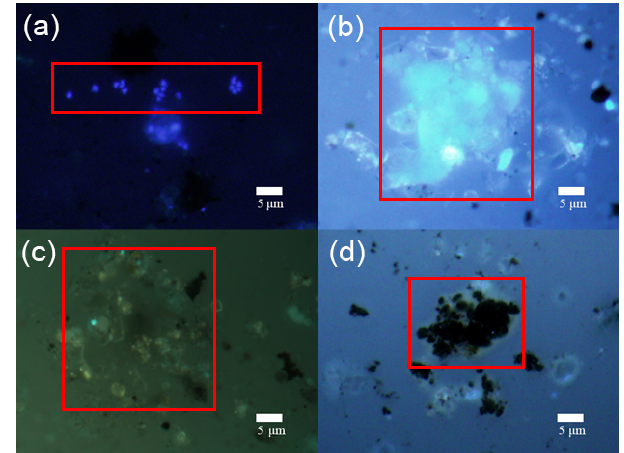
Figure 5. Epifluorescence micrograph of (a) DAPI-stained bacte- ria (with diameters <3µm), (b) white particles (mineral particles), (c) yellow particles (organic matter), and (d) black particles (black carbon) in air samples. All photomicrographs were taken at a mag- nification of ×